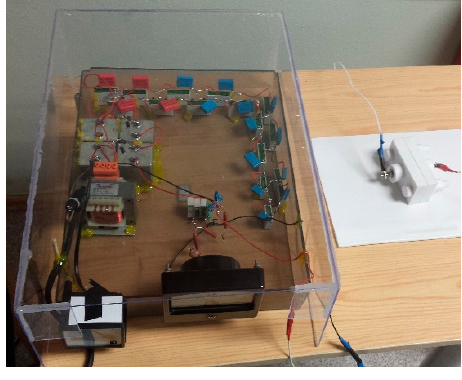
Figure 1. Pole alignment set.